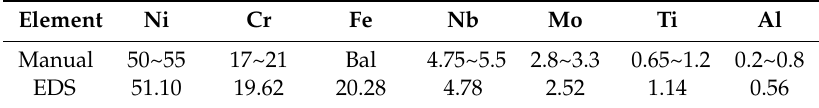
Table 1. Limiting chemical composition (Mass%).